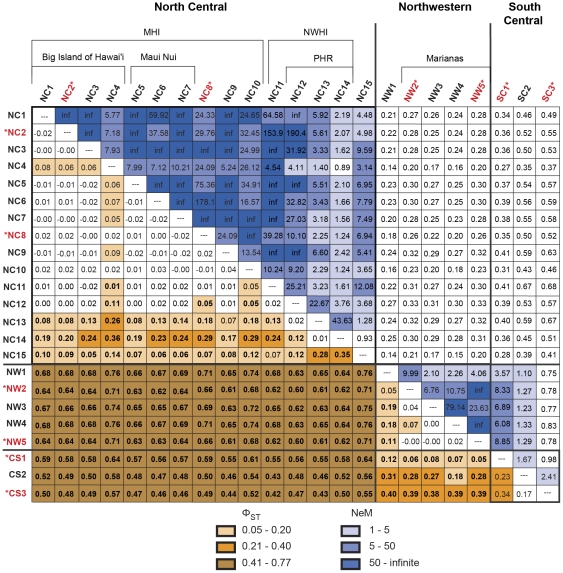
Pairwise ΦST (below diagonal) and effective migration rates (above diagonal) for Acanthaster planci population samples within each Pacific region.Statistically significant, accounting for family-wise false discovery error rate, is noted in bold face type (α* = 0.0354). PHR is Pearl & Hermes Atoll, MHI is main Hawaiian Islands, and NWHI is Northwestern Hawaiian Islands. Island codes are as follows: NC1 Hawai'i 1982, NC2* East Hawai'i, NC3 South Hawai'i, NC4 West Hawai'i, NC5 Lāna'i, NC6 Maui, NC7 Moloka'i, NC8* O'ahu, NC9 Kauai'i, NC10 Ni'ihau, NC11 French Frigate Shoals, NC12 PHR forereef, NC13 PHR backreef, NC14 PHR lagoon, NC15 Johnston Atoll, NW1 Yap, NW2* Guam, NW3 Rota, NW4 Pagan, NW5* Asuncion, CS1* Kingman Reef, CS2 Swains Island, and CS3* Mo'orea. Outbreak populations are * and in red.